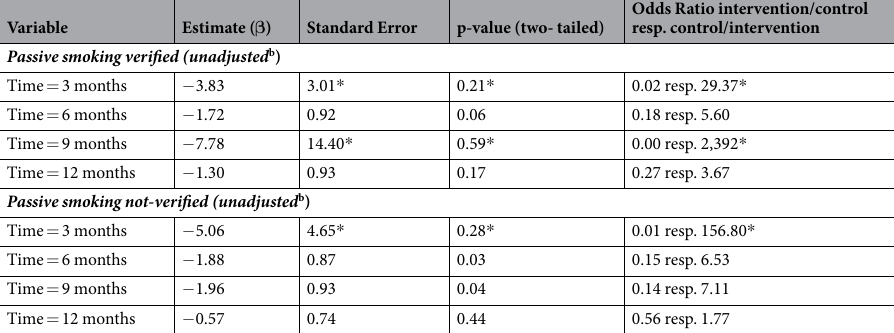
Table 3. Model estimates a for group difference between intervention and control group (reference) for urine cotinine verified and not-verified parental report of passive smoking in children. Odds ratio of exposure for treated versus control respectively for control versus treated. a GLMM, dependent variable passive smoking (yes (1) or no (0)). b Unadjusted: analysis without gender and age as covariates. * Large Standard Error, p-value and Odds Ratio due to zero non-exposed in the control group (see Table 2).